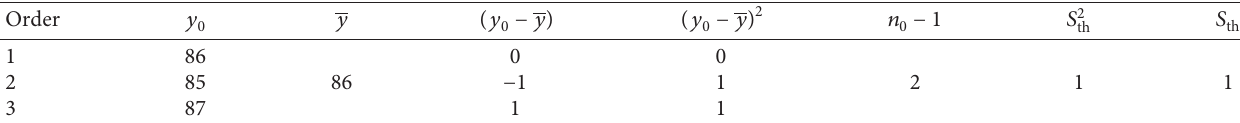
Table 5: The reproductive variance.